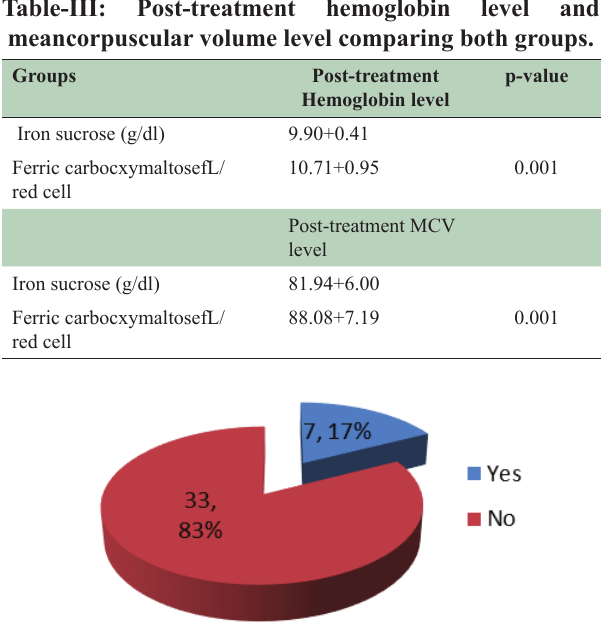
Figure-I: Presence of Body rash in intravenous Iron sucrose group.